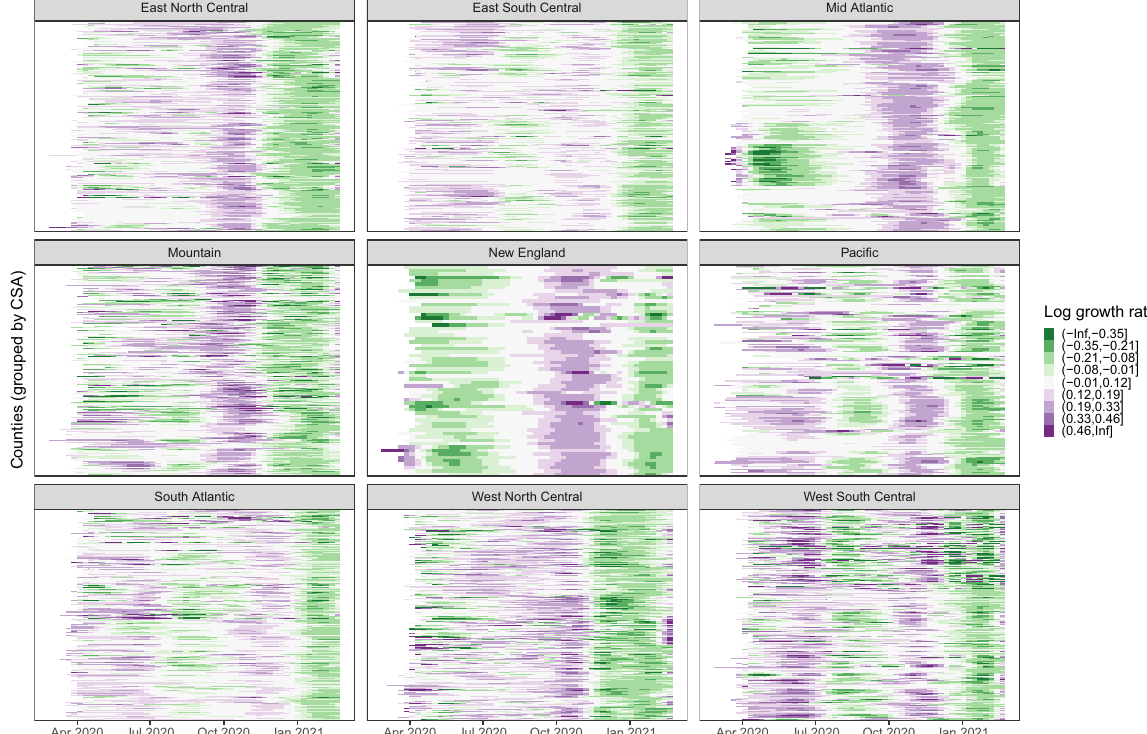
Fig. 1 Weekly log infection growth rate y i , t of the inferred true incidence of infection. Each county i is faceted into panels by its US Census division. Within a panel, each row represents a county, and counties in the same combined statistical area (CSA) are grouped together in adjacent rows. For example, the cluster of rows in the bottom third of the Mid Atlantic with rapidly declining growth rates in April 2020 represent counties in the New York-Newark CSA. Counties within the same CSA tend to exhibit similar trends in log growth rate. At a high level, the national surge in fall 2020, followed by declining infection rates in early 2021 is